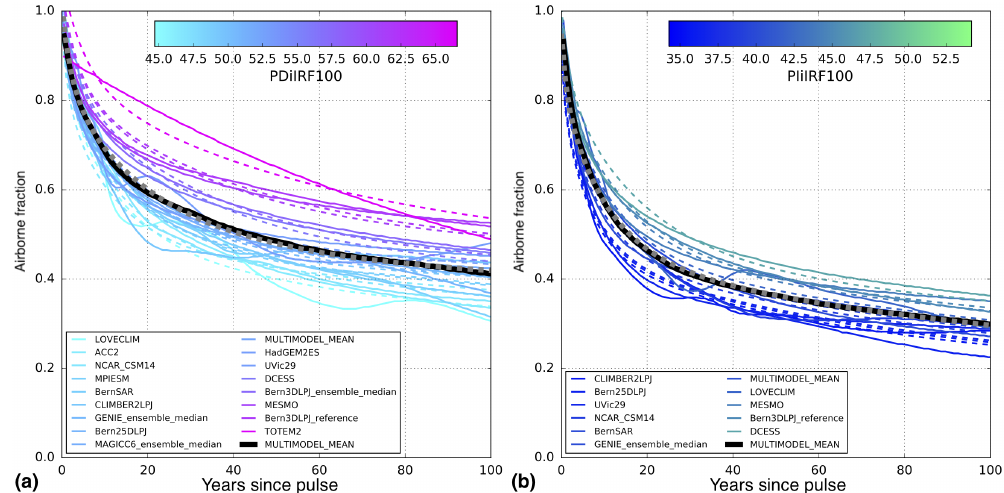
Figure 4. Fitting individual models from Joos et al. (2013) with FAIR. (a) shows the remaining airborne fraction for the PD100 experiment and (b) for those models that additionally completed the PI100 experiment. Solid lines show the original model response coloured by the iIRF 100 values. Emulations with FAIR are shown by the same coloured dashed lines. The multi-model mean is shown by a solid black line with the FAIR fit denoted by a dashed grey line. Table 2. iIRF 100 values in the experiments and models shown in Fig. 3. The star indicates that the values for suppressed climate–carbon-cycle feedbacks are calculated assuming the 13% (PI100) and 15% (PI5000) reductions in iIRF 100 from the fully coupled experiment observed from the Bern3D-LPJ model in Joos et al. (2013), the only model which conducted the experiments. Brackets indicate the ± 2 standard deviation ranges around the multi-model mean in Joos et al.